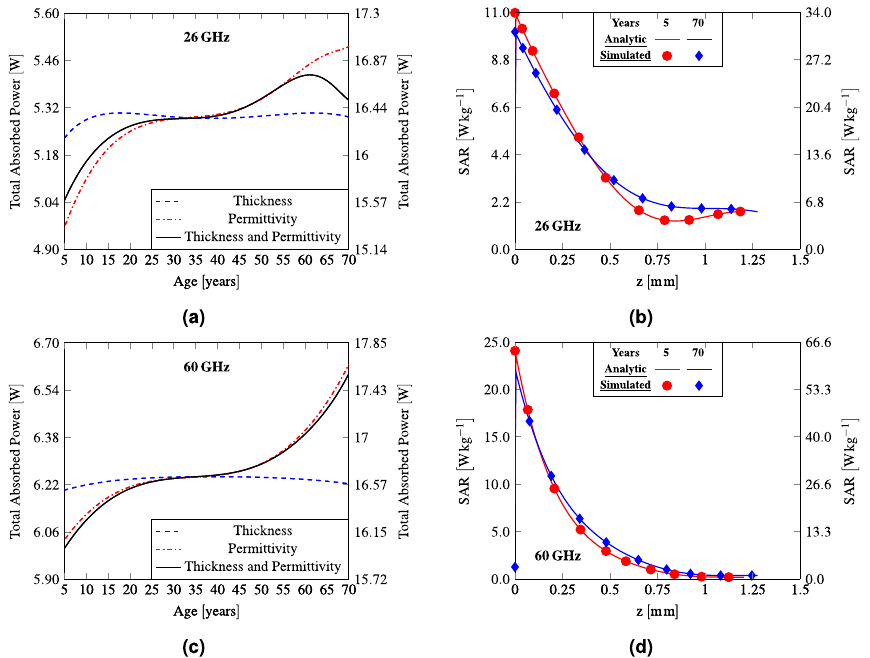
Figure 4. ( a , c ) Total absorbed power, ( b , d ) SAR distributions in the skin layer as a function of skin thickness, tissue permittivity, and combination of the two. The left y axis refers to IPD equal to 10 W m − axis corresponds to the frequency dependent IPD limits for local exposure.